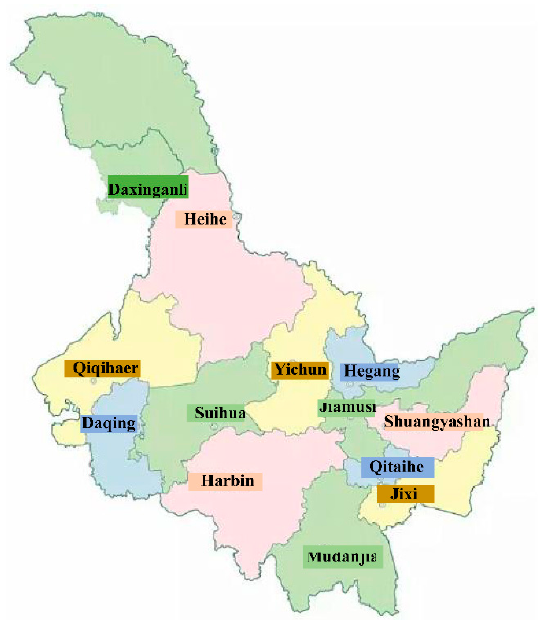
Figure 1. Geographic distribution of 242 wild soybean samples in Heilongjiang Province.